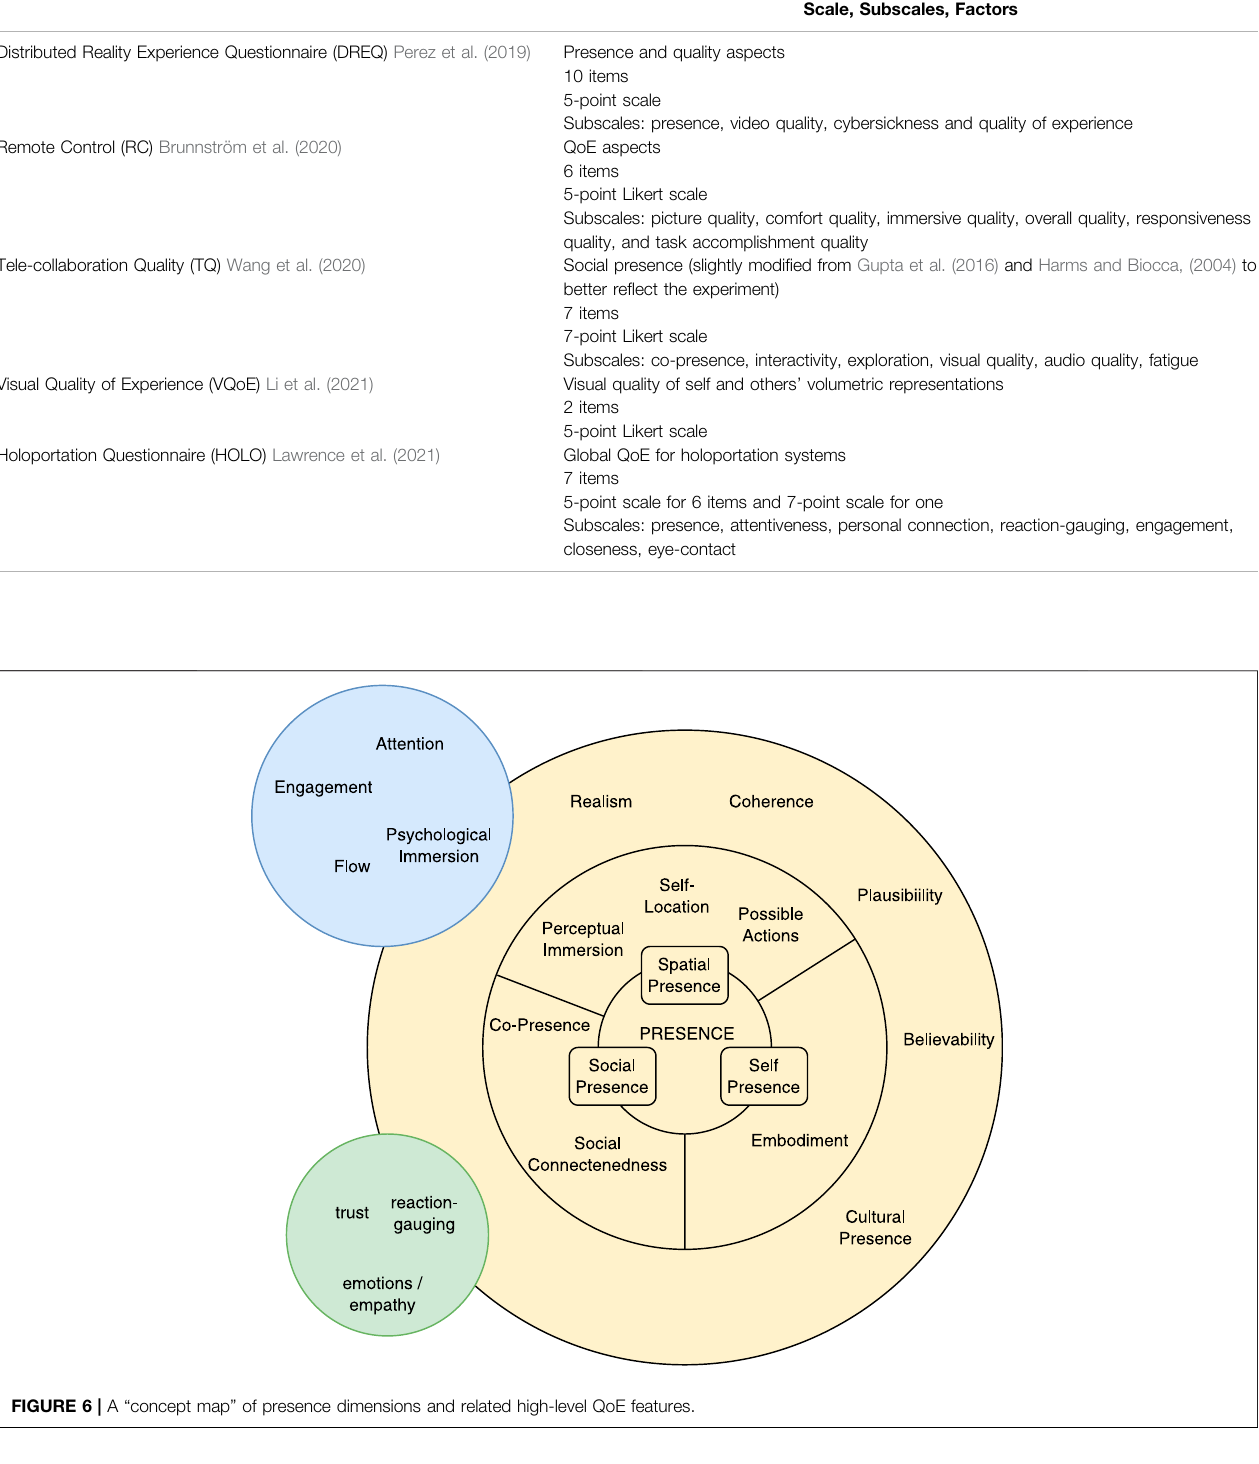
of QoE, de fi ned four levels: direct perception, interaction, usage situation, and service. Another example is provided by Chen et al. (2012) (and standardized in the ITU-R recommendation BT. 2021